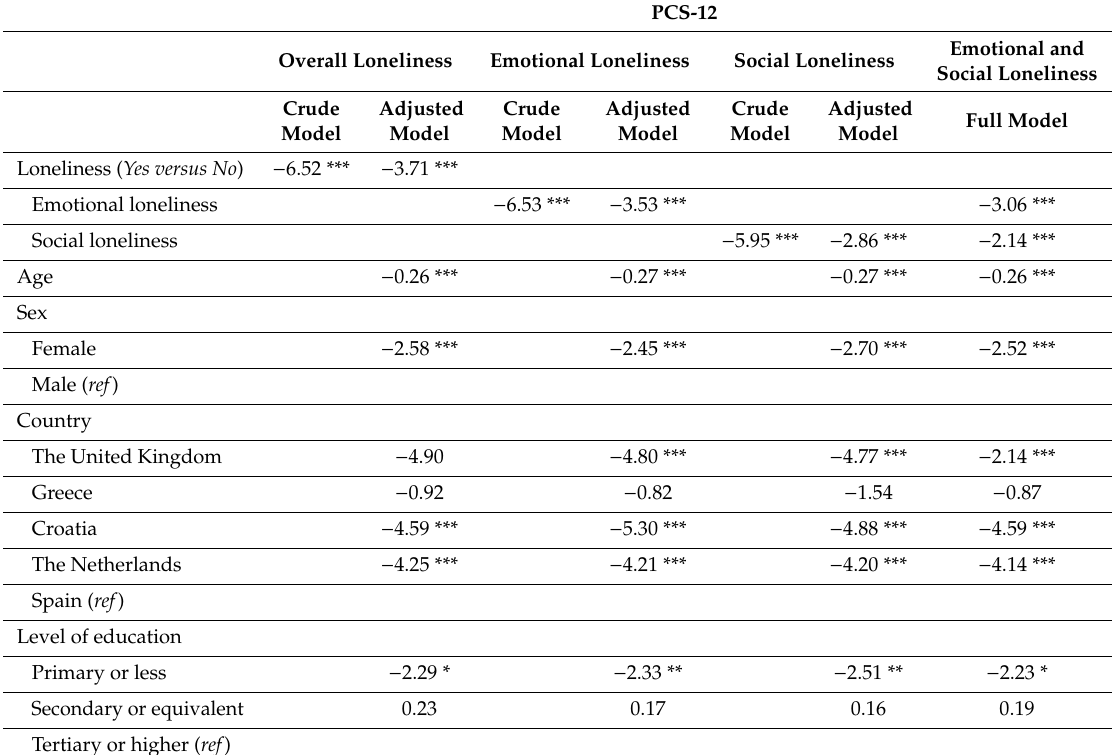
Table 4. Association between loneliness and physical Health-Related Quality of